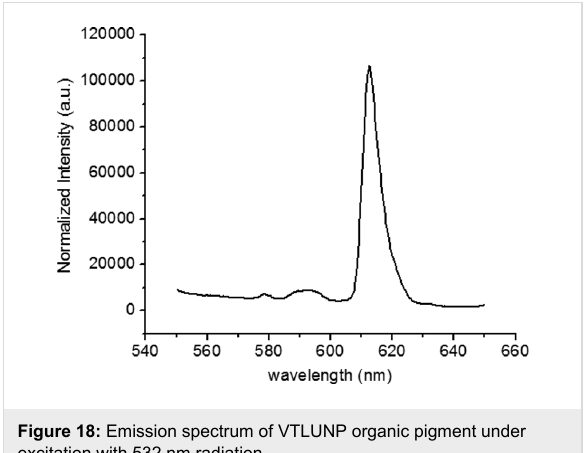
Figure 18: Emission spectrum of VTLUNP organic pigment under excitation with 532 nm radiation.